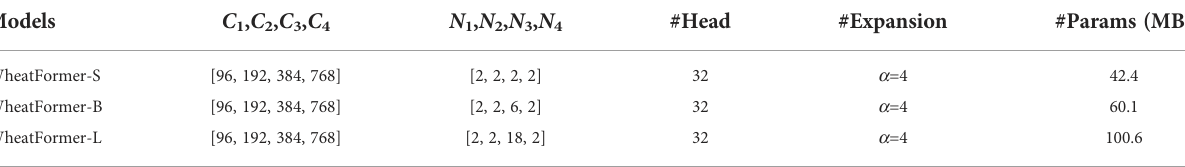
TABLE 2 Detailed settings of WheatFormer